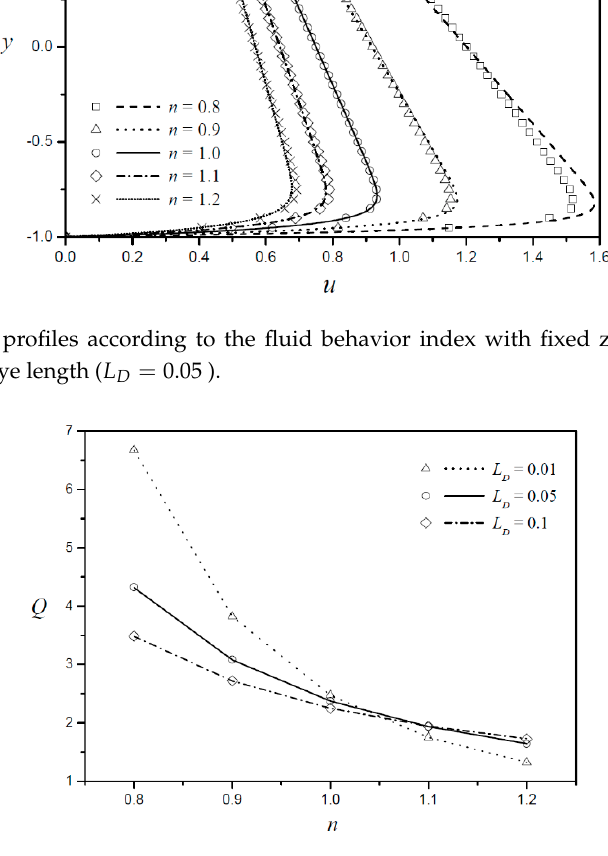
Figure 7. Dimensionless flow rate according to fluid behavior index ( n ) for different Debye lengths ( L D ) with a fixed zeta potential ratio ( Z R = 1.5 ). Table 1. Flow rate error (%) between approximate solution and numerical analysis at Z R = 1.5.